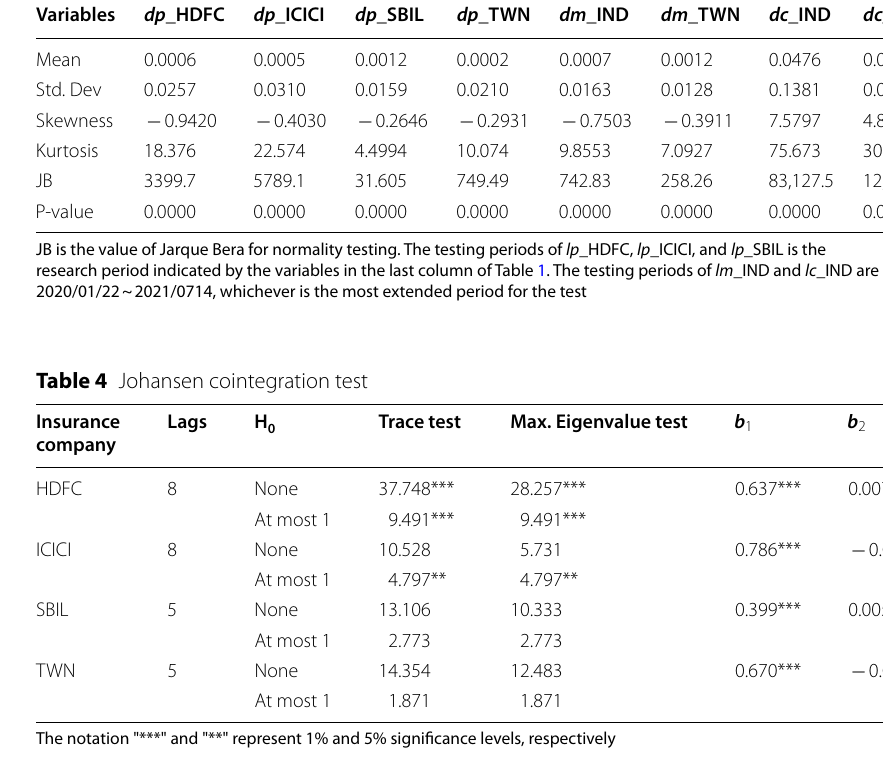
Table 3 The descriptive statistics of the variables